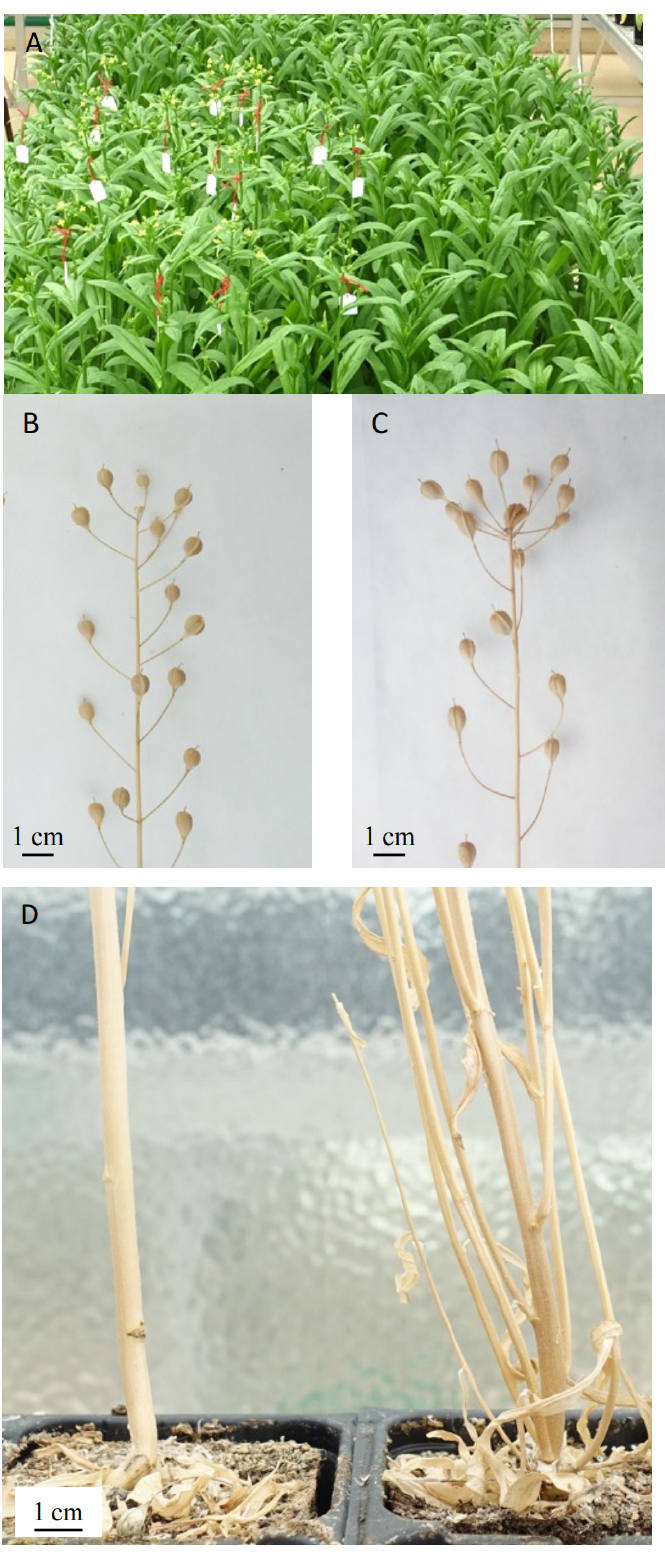
Figure 2. Novel phenotypes observed in the T3, T4, and T5 plants. Overview ( A ) of an early-flowering progeny ( left ) and controls ( right ) shown 30 days after sowing. Main branch of a mature control plant ( B ), and a plant showing a strong determinate growth phenotype with a terminal seed pod ( C ). In ( D ) are shown a control plant ( left ), and one showing abundant basal branching ( right ). Seeds borne by the T5 plants were photographed using an Axiozoom (Zeiss), and images were segmented by ′ distance transform watershed ′ as implemented in the Mor- pholibJ plugin [42]. The quantification of the areas was extracted as described in [43]. R software was used to run the wilcoxon.test for plant height, number of basal stems, and seed yield; however, the Student test was used for seed size.